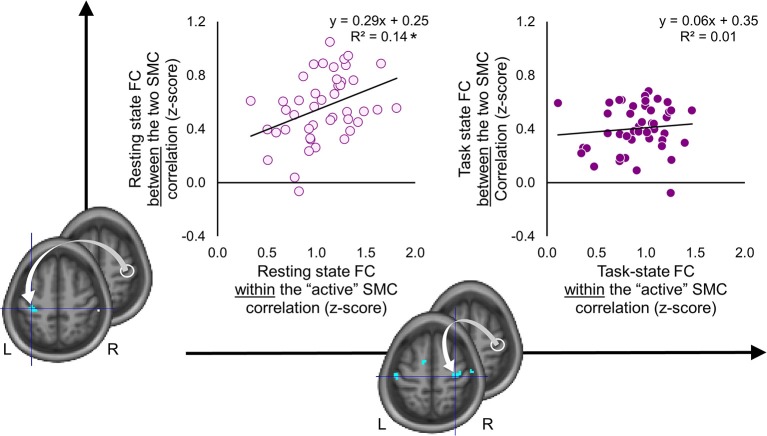
Task-induced segregation between the two somatomotor cortices. Individual functional connectivity (FC) values between the two somatomotor cortices (SMC) (vertical axis) are plotted against FC values within the “active” SMC (horizontal axis) during the resting and task state (left and right plots, respectively). The FC values were calculated between the ROI within the “active” SMC (white circle) and peak voxels of clusters resulted from the whole-brain FC analyses, which were conducted using behavioral measures as covariates of interest (for details see Figures 5, 6). L and R—left and right hemisphere, respectively. *significant correlation at 0.01 level. During the resting state, FC between the two SMC was positively correlated with FC within the “active” SMC. No such relationship was observed during the task state.